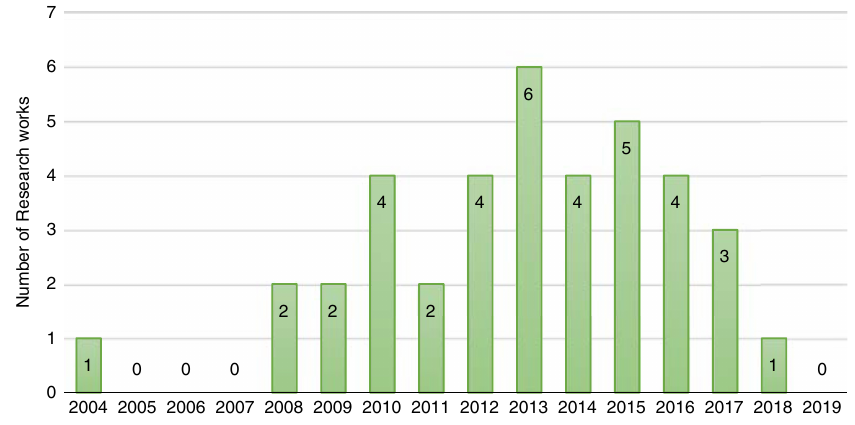
Figure 1. Distribution of